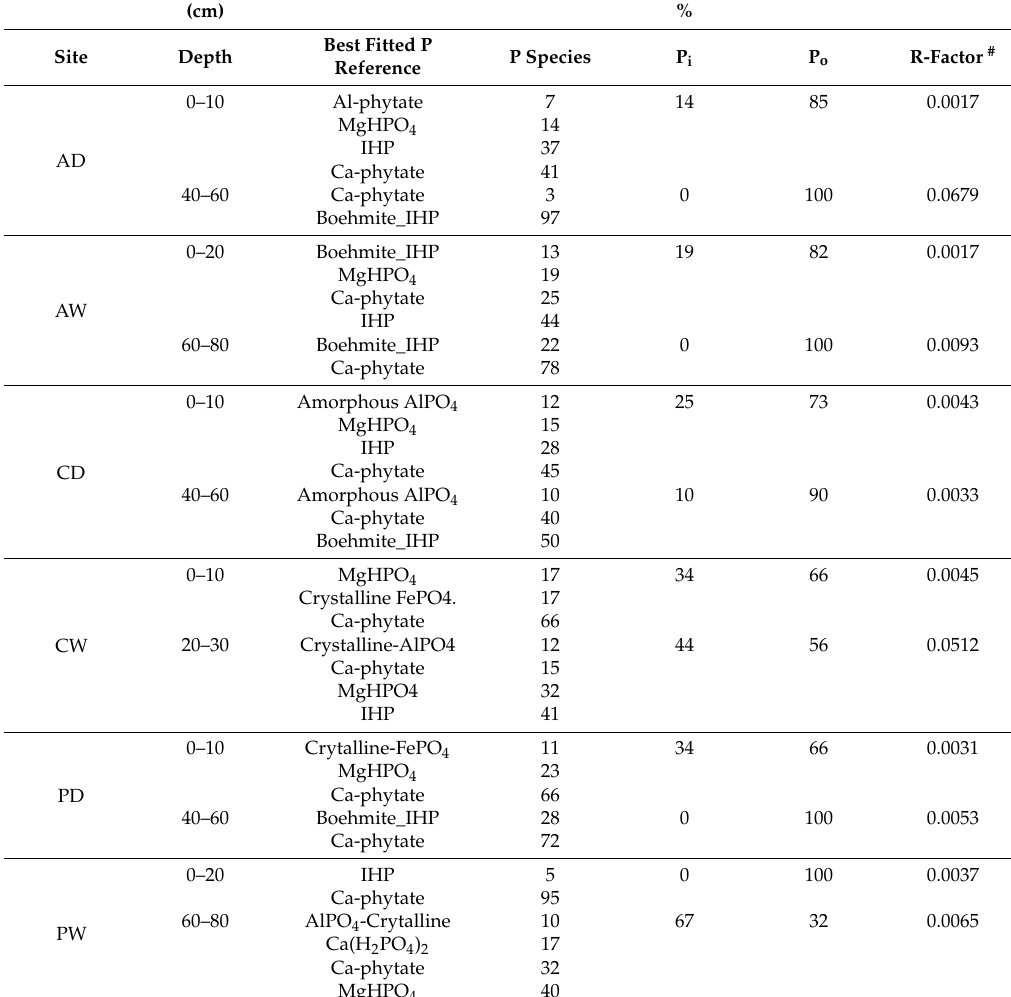
Table 6. Phosphorus species, P i, and P o determined by P K X-ray absorption near-edge structure (XANES)